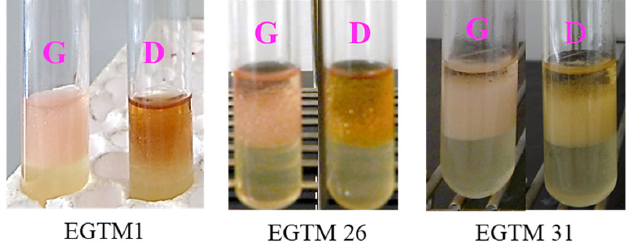
Figure 2. Emulsification of gasoline (G) and diesel (D) by bacterial strains. Micrococcus luteus Figure 2 . Emulsi fi cation of gasoline (G) and diesel (D) by bacterial strains. Micrococcus luteus EGTM1, Enterobacter cloacae EGTM26, and Leclercia adecarboxylata EGTM1, Enterobacter cloacae EGTM26, and Leclercia adecarboxylata EGTM31.